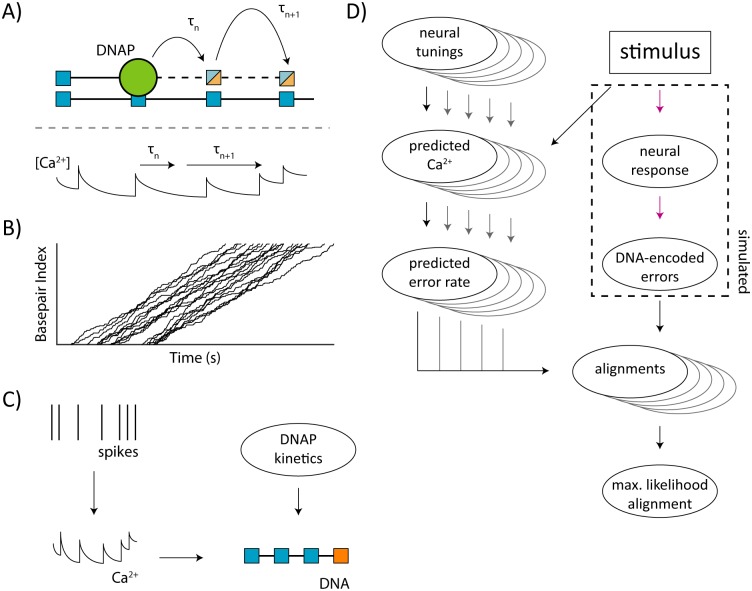
Procedural overview.A) Molecular recording overview. A DNAP (green) copies a template DNA strand of known sequence. It can incorporate the correct Watson-Crick paired nucleotide (blue) or make an error and incorporate a non-paired nucleotide (orange). These incorporations and misincorporations can be read out via DNA sequencing. The time τ between these nucleotide incorporations is variable and a function of DNAP kinetics. While these nucleotides have regular DNA-based indexing, they have irregular indexing with respect to time. B) Examples of nucleotide-time mappings, simulated as described in Methods. Stochastic DNAP kinetics produce non-linear nucleotide-time mappings. Further, diffusion and other biological processes can lead to non-uniform recording start times. C) Generative model for DNA-based error signals. Neural spikes lead to elevated calcium levels in the neuron. These changes in calcium alter the instantaneous error rate of a molecular recorder. These changes in error rate are only recorded when nucleotides are incorporated into a DNA strand, causing the resulting DNA-based record to be a function of cellular calcium and DNAP kinetics. D) Overview of alignment and inference. We begin with a set of potential neural tunings and a time-varying stimulus. The stimulus is transformed by the neuron to neural activity, which is then recorded as errors in a DNA strand by a molecular recorder. In parallel, we use the set of potential neural tunings in combination with the observed stimulus to generate estimates of neural calcium and the resulting instantaneous DNAP error rate. We use our algorithm to align the DNA-based errors to each of the estimated error-rate traces, then select the maximum-likelihood alignment. Dashed box indicate biological processes that are simulated in parts of these analyses.